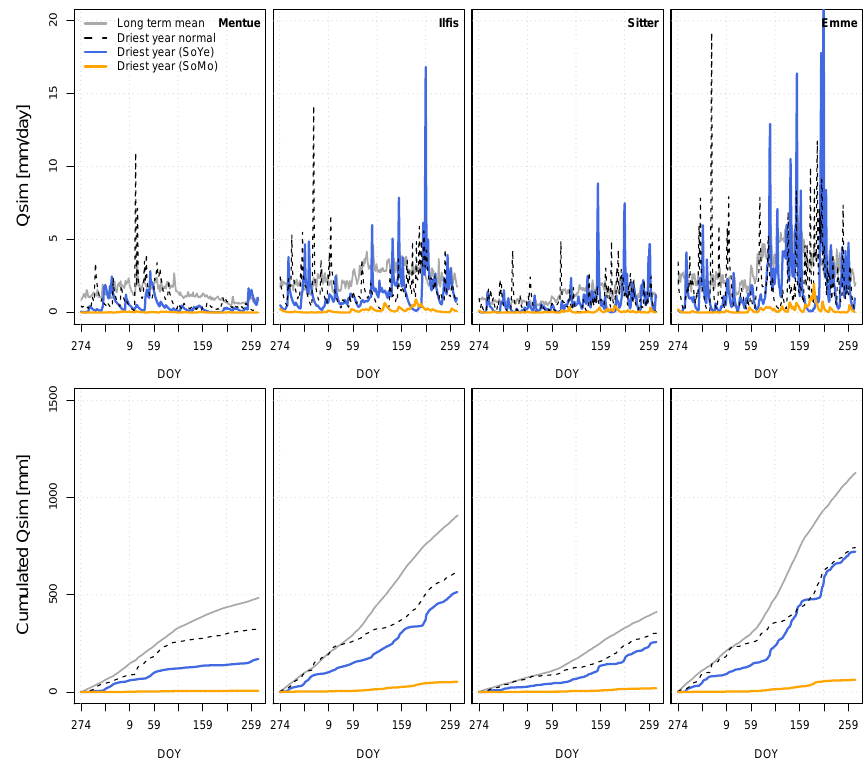
Figure 4. Q sim and cumulated Q sim for long-term mean, driest year of the reference simulation as well as the driest years of the two scenarios for four example